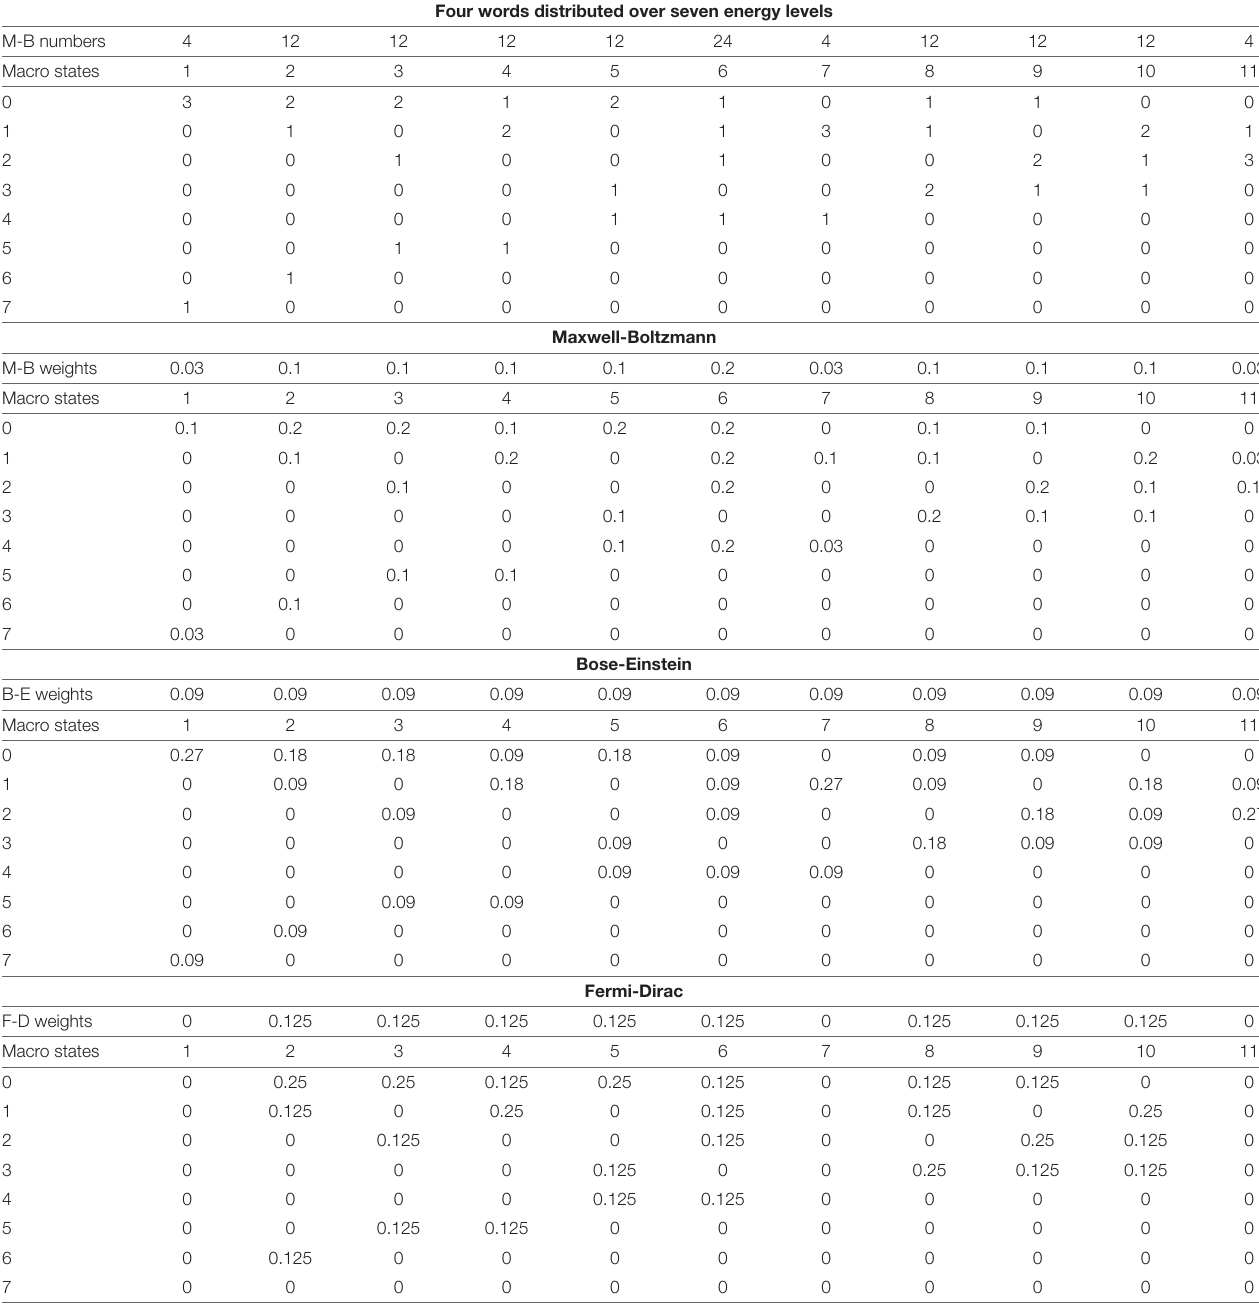
TABLE 2 | The data of an example consisting of four words distributed over seven energy levels with total energy equal to seven. Four words distributed over seven energy